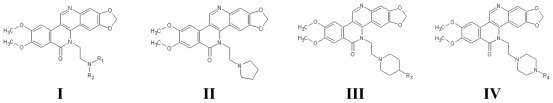
Four types of ARC-111 analogues structures.